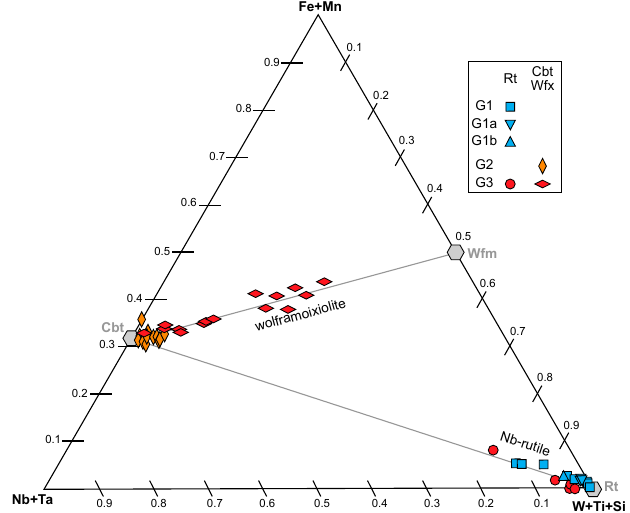
Figure 23. Panasqueira colombite-tantalite, wolframo-ixiolite, and rutile compositions in the Nb + Ta/Fe + Mn/W + Ti + Si triangular diagram.